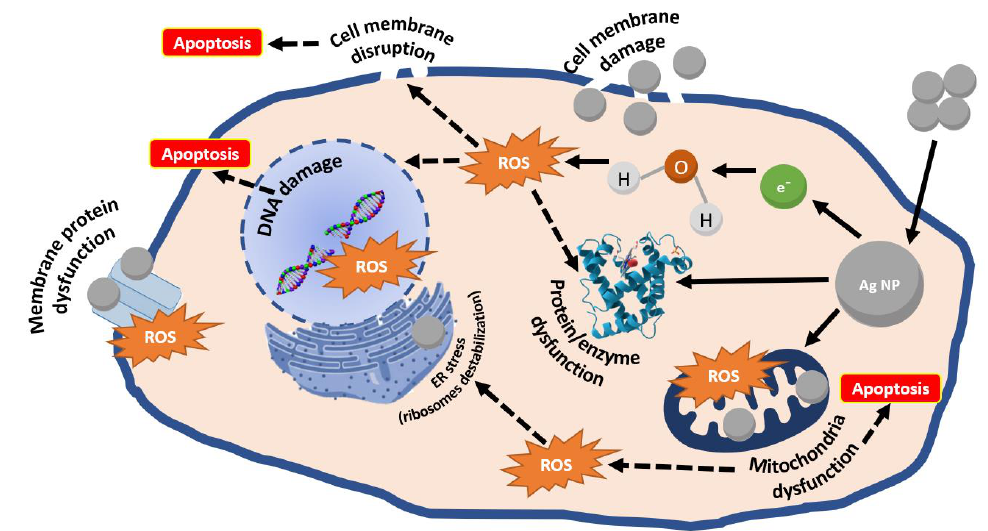
Figure 3. Schematic representation of Ag NPs anticancer mechanisms of action. Created based on information from [44,49,50].